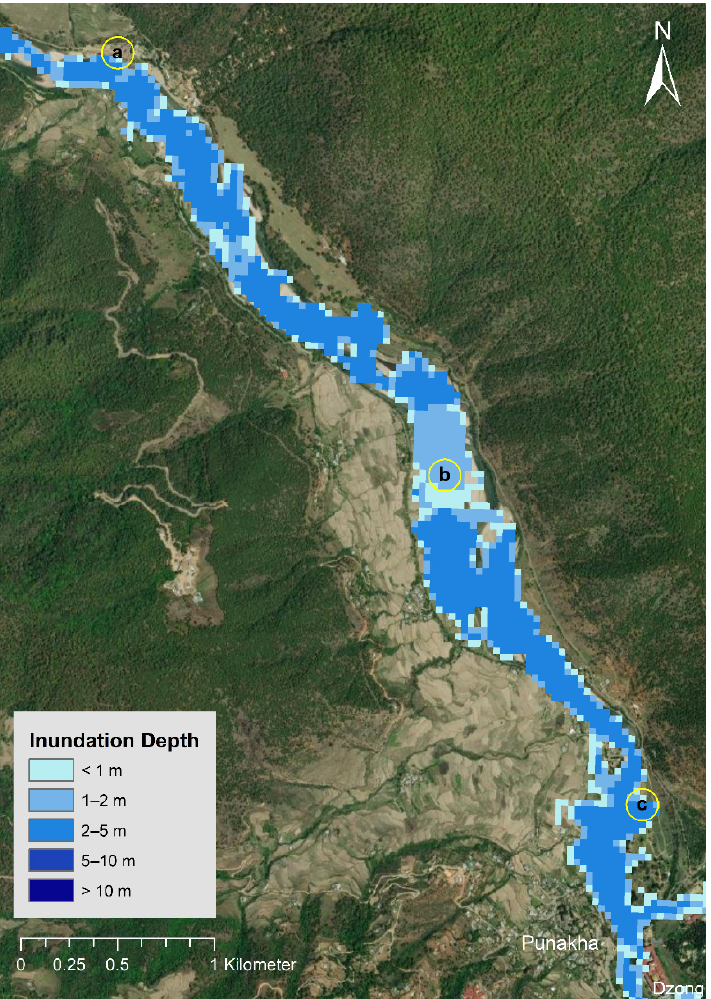
Figure 8. Maximum flood depth for the worst case scenario (see text for explanations) in Punakha, based on SRTM elevation data. Letters a–c (marked by yellow circles) indicate the location of affected buildings. Backgound map: World Imagery (Source: Esri, Maxar, Earthstar Geographics, USDA FSA, USGS, Aerogrid, IGN, IGP, and the GIS User Community).